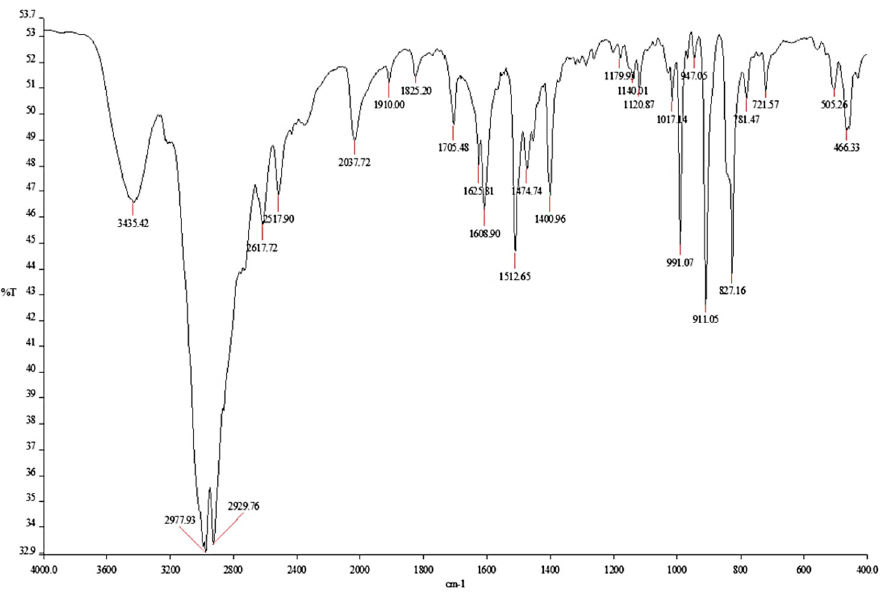
Figure 1. FTIR (KBr) spectrum of monomer M5 ( 5 ).